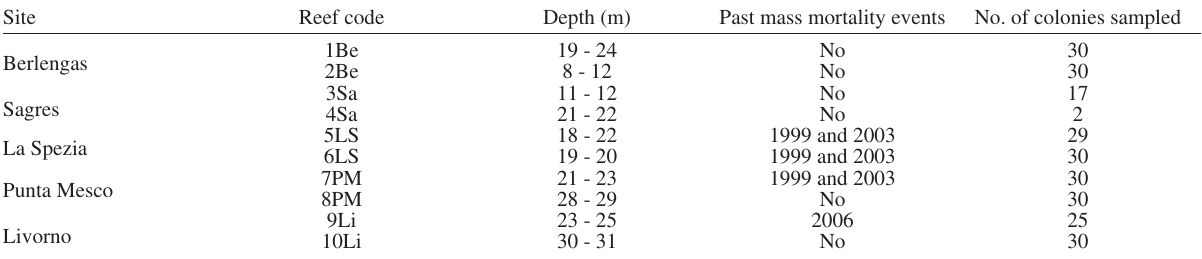
Table 1. – Sampling site characteristics: depth range of sampled reefs, year of past mass mortality events and number of the P. clavata colonies sampled at each